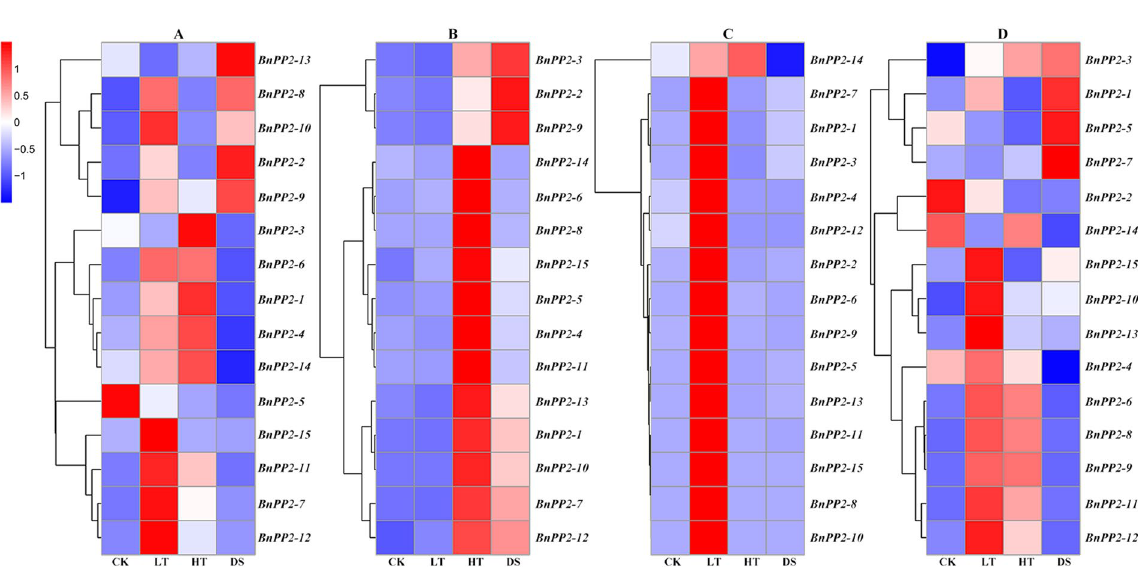
Figure 4. The relative expression level of BnPP2 genes within four tissues in ramie under LT, HT and DS treatments. ( A–D ) indicates leaf (without main vein), petiole, bark and stem, respectively. The relative expression level (REL) was distinguished by the color of the gradient, the red for high expression level, while the blue for low expression level. The expression levels (using eEF1 α as the endogenous control) were transformed (log 1 + REL ) into colors in order to assess their overall expression levels. CK, plants from the normal condition for control; LT, low temperature; HT, high temperature; DS, drought stress. The color key in the upper left corner of the